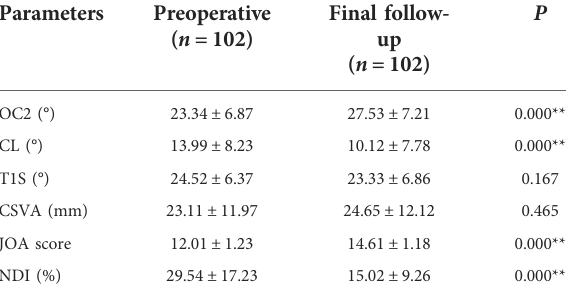
TABLE 1 Comparison of cervical sagittal parameters and patient- reported outcome indicators pre- and postoperatively. Parameters